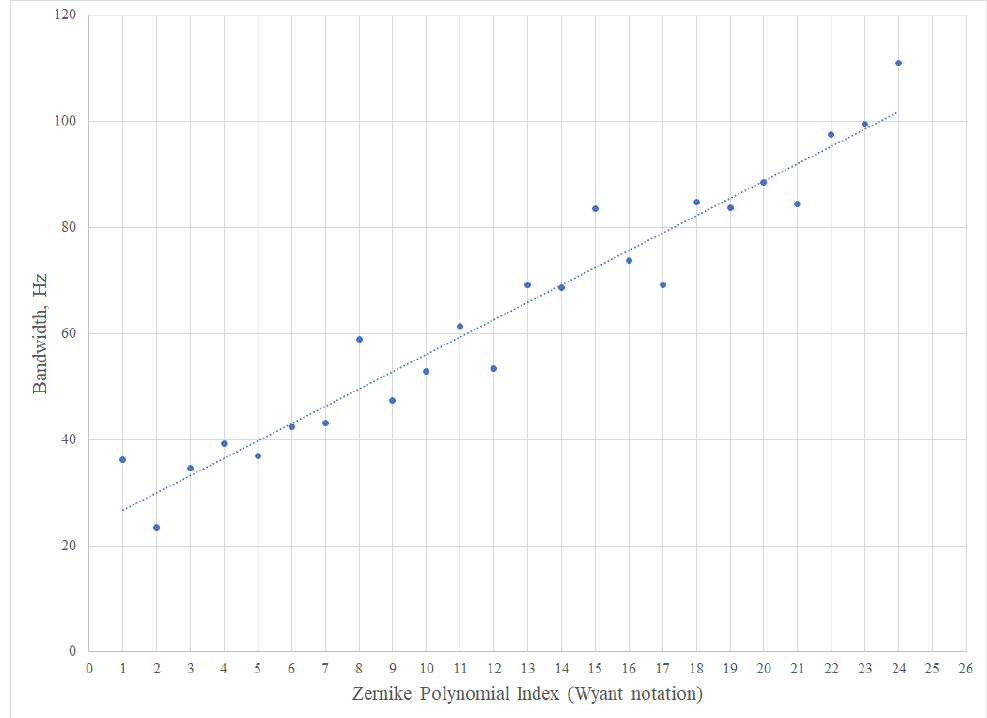
Figure 11. The frequency band occupied by one or another aberration. The spectral energy saturation amplitude from Figure 10 for each Zernike polynomial is shown on Figure 12.